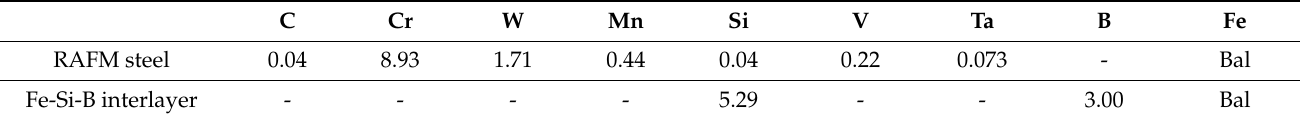
Table 1. Chemical composition of materials for experiments